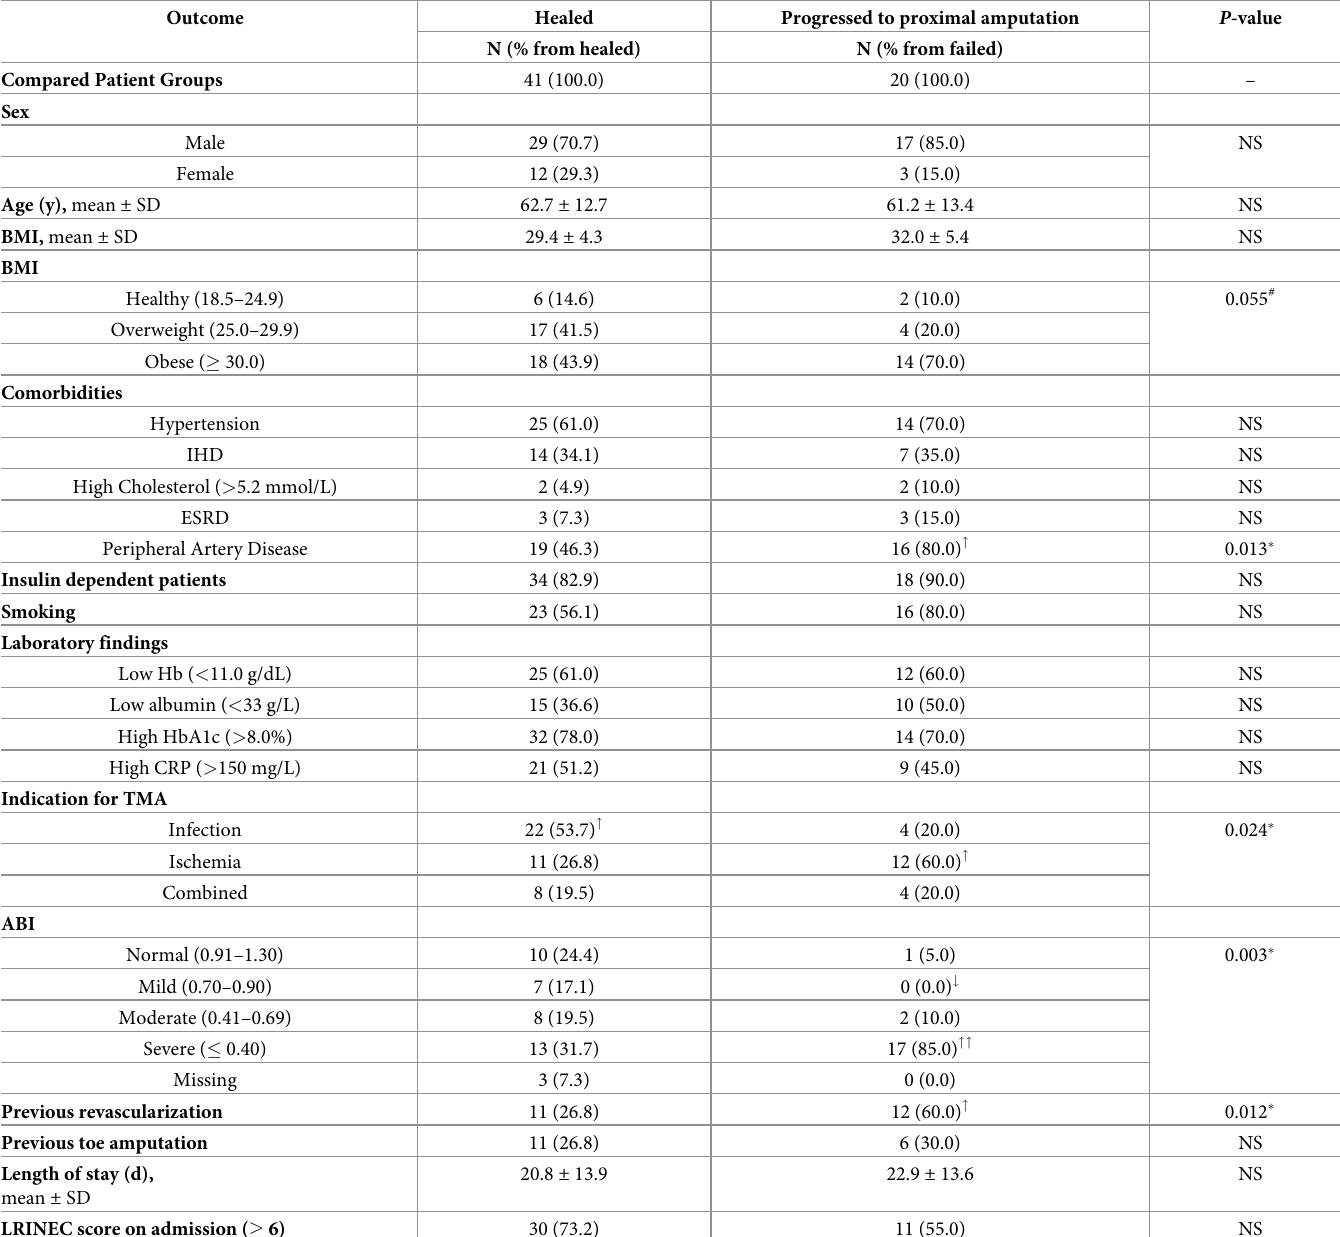
Table 4. Factors associated with the transmetatarsal amputation (TMA) patients who progressed to proximal